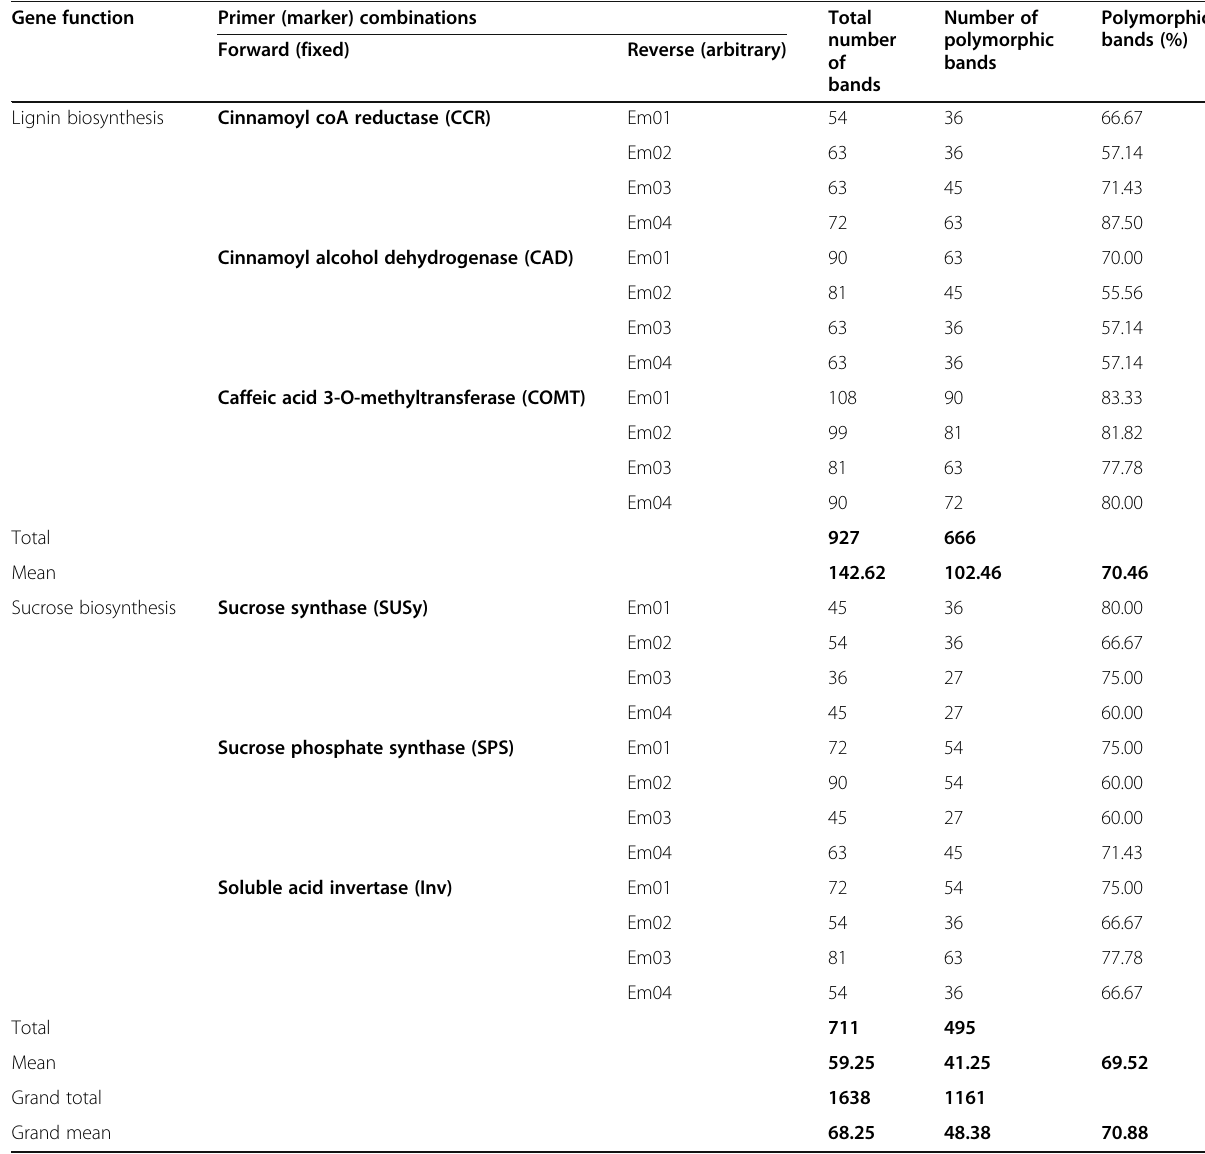
The resolving power of the markers ranged from 5.40 markers based on lignin related genes ranged between (CAD/EM03) to 17.80 (COMT/EM01) for markers 55.56 and 87.5%, while the range for their sucrose-based based on lignin-related genes while it ranged from 4.80 counterparts was 60 to 80% (Table 3). The polymorphic in- (SUSy/EM03) to 10.93 (SuSy/Em3 and COMT/Em1) for formation content (PIC) computed as a mean over all the markers based on sucrose metabolism genes. The mean genotypes ranged from 0.22 (SPS/EM04) to 0.45 (SPS/ resolving power was 8.86 for all markers tested over the EM01) for sucrose related markers and 0.18 (CCR/EM04) genotypes. However, lignin-based markers showed a to 0.42 (CCR/EM03) for lignin related markers (Table 4). relatively higher RP (9.97) as compared to sucrose- The overall average PIC displayed by all marker combina- related markers (7.74). The marker with a higher RP tions was 0.32 that showed moderate to higher informative- (COMT/Em1) had a higher capability to distinguish ness of the marker. Both groups of TRAP marker systems among the genotypes. The marker index ranged from designed based on sucrose and lignin related genes showed almost similar PIC value (0.32 and 0.33), respectively. Table 3 Polymorphism of 24 TRAP marker combinations on 30 sweet sorghum genotypes Gene function Primer (marker) combinations Total Number of Polymorphic number polymorphic bands (%) Forward (fixed) Reverse (arbitrary) of bands bands Lignin biosynthesis Cinnamoyl coA reductase (CCR)